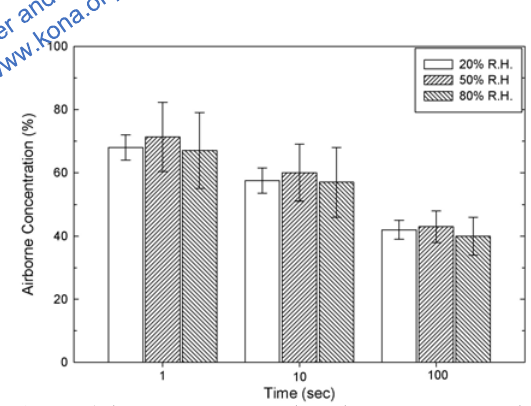
Airborne concentration of bare aluminum at 20, 50, and 80% humidity. Using liquid CO 2 dissemination, the usual effect of increasing relative humidity on increasing agglomeration is no longer a factor due to the improved dispersion method.